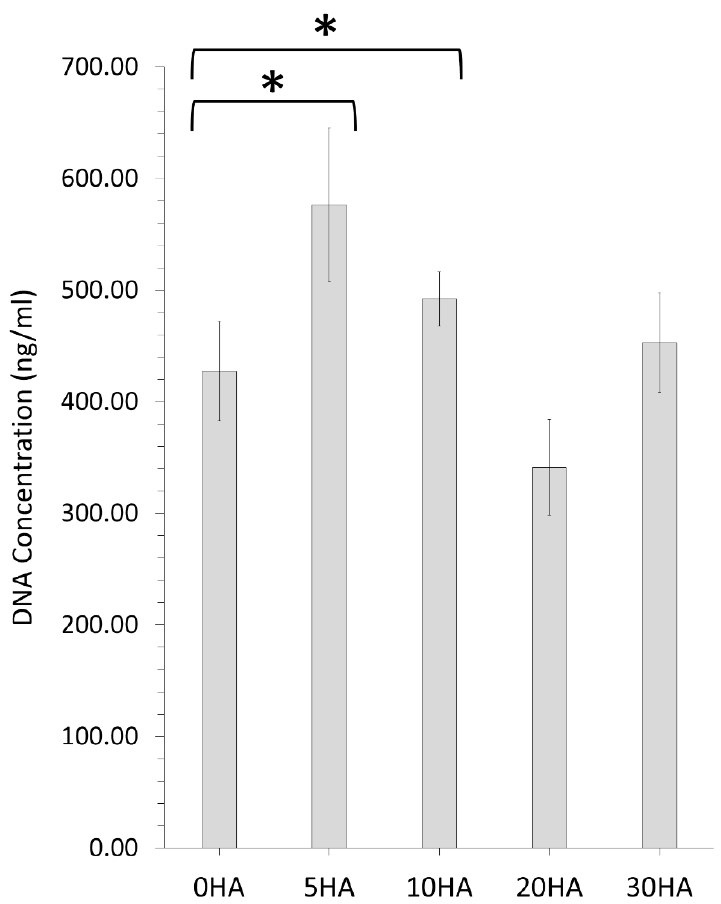
Figure 13. PicoGreen™ assay results representing DNA concentration for U-2 OS cells adhered to